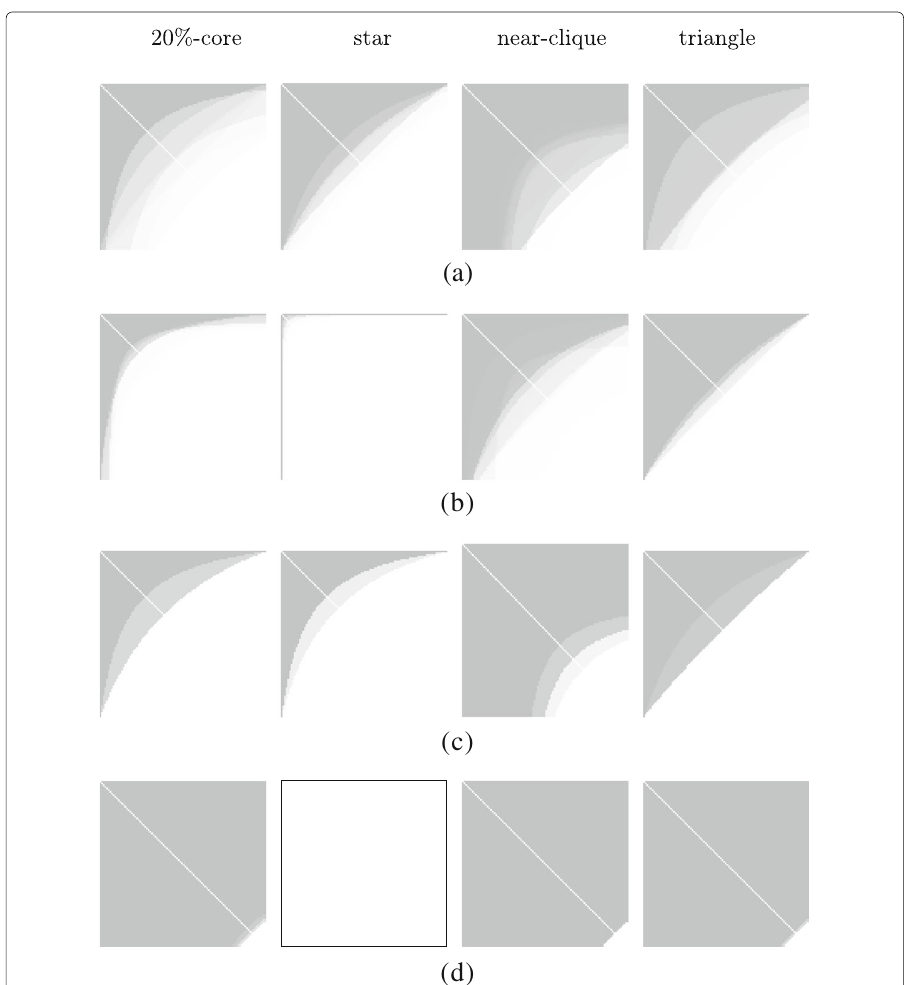
Fig. 5 Hyperbolic model fitted on results of alternate generators. Each subfigure summarizes 50 repetitions of using the alternative generator to fit the respective input displayed in Fig. 3. For every sample, the adjacency matrix of the closest hyperbolic model is displayed in light grey. Shades of grey result from overlaying all samples and yield a visual summarization of the observed shapes. The ideal result would be